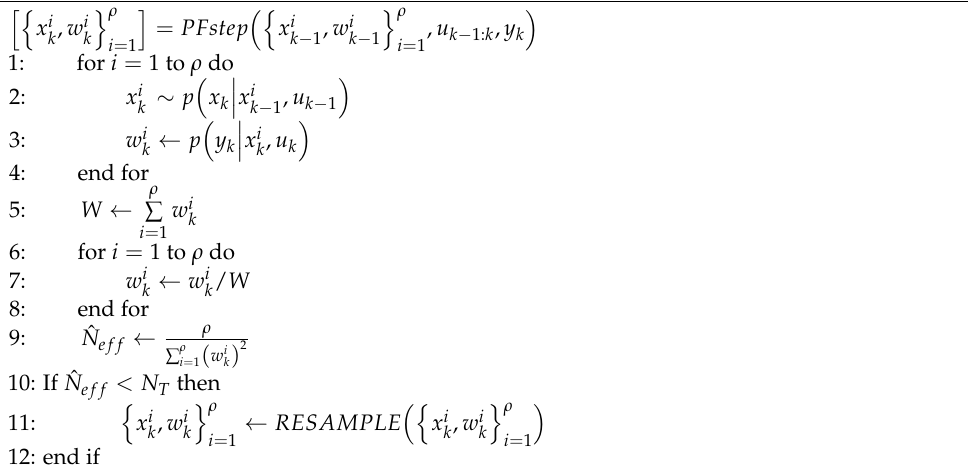
Algorithm 2: Sample Importance Resampling Particle Filter